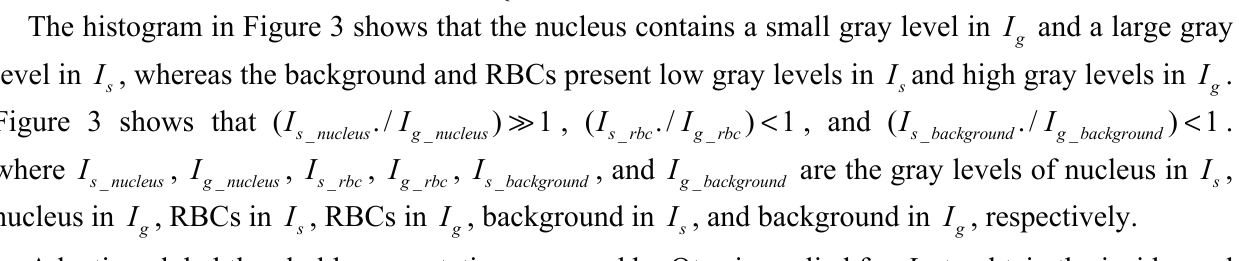
binary figure. The mathematical morphology method is used to eliminate platelets or other